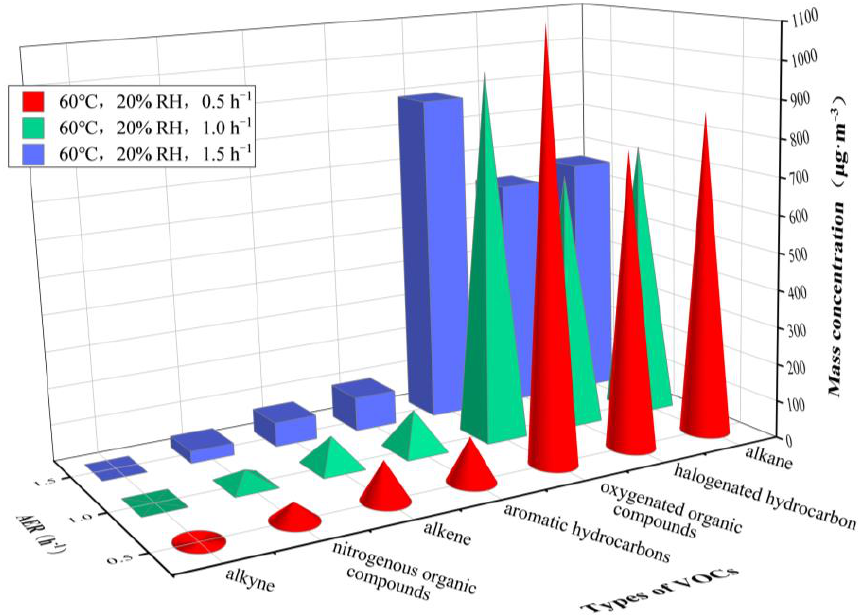
Figure 8. Mass concentrations of VOCs released from plastic track at AERs varying from 0.5 to 1.5 h −1 . Temperature = 30 °C and RH = 45%.